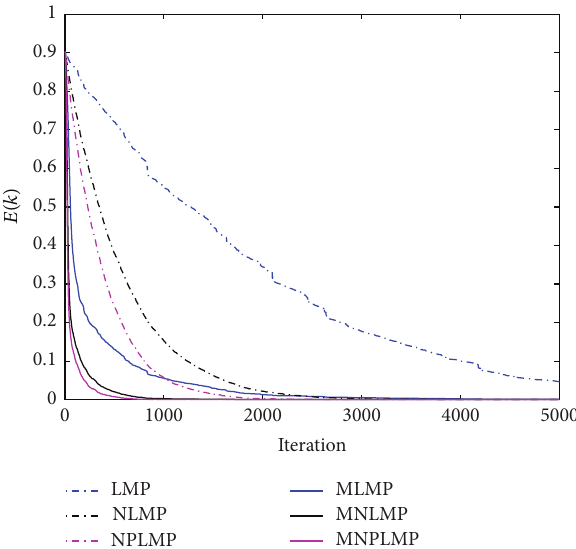
Figure 8: Corresponding stable error history